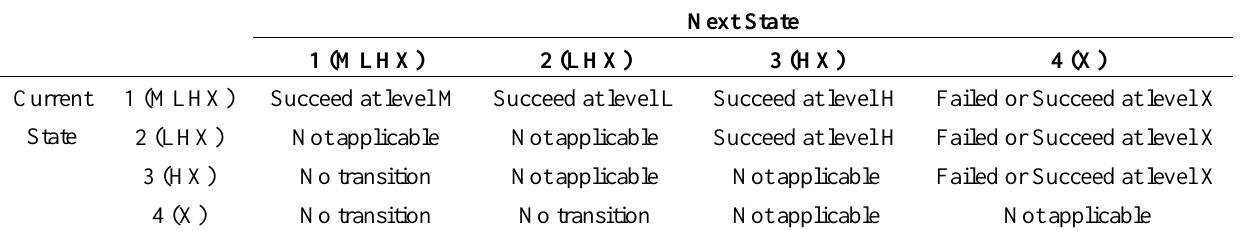
Table 3. State transition matrix when state levels go up.